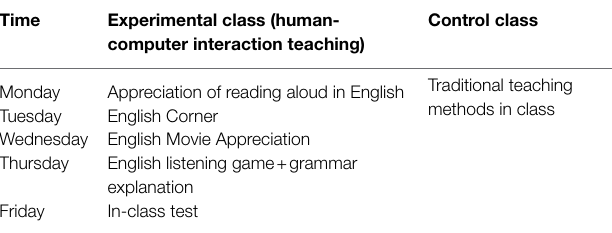
TABLE 2 | Schedule of experimental courses.